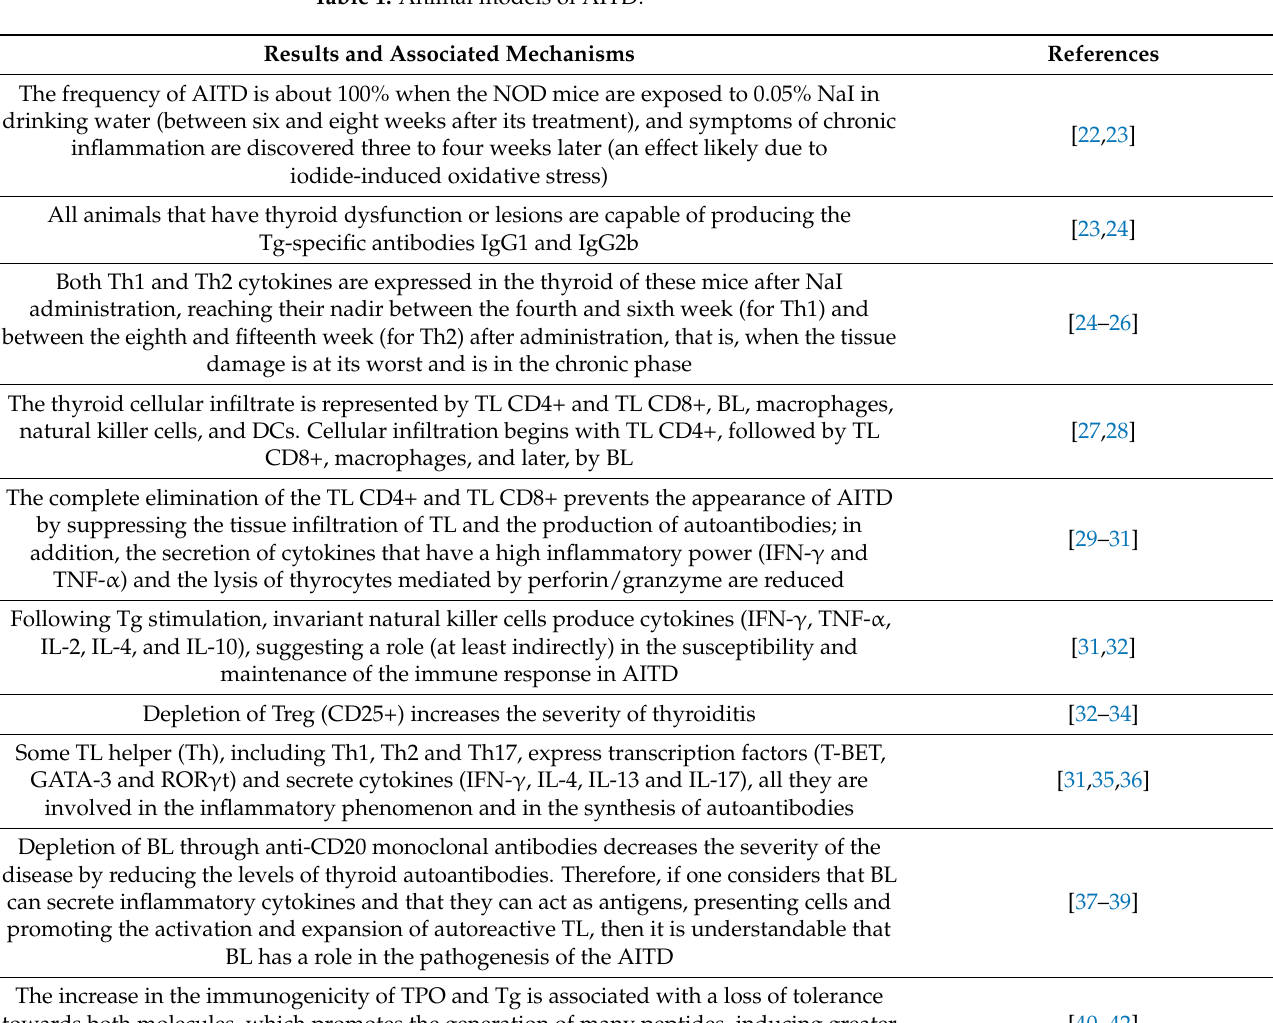
Table 1. Animal models of